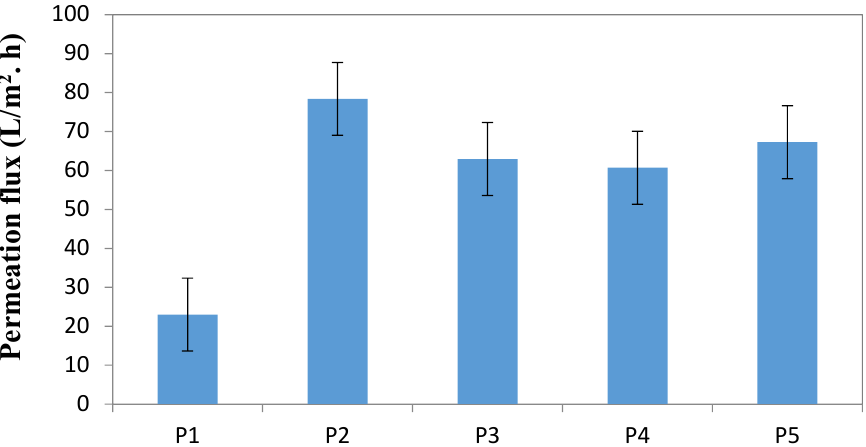
Figure 8. E ff ect of PES content on pure water flux (L / m 2 h) of Figure 8. Effect of PES content on pure water flux (L/m 2 h) of membranes.